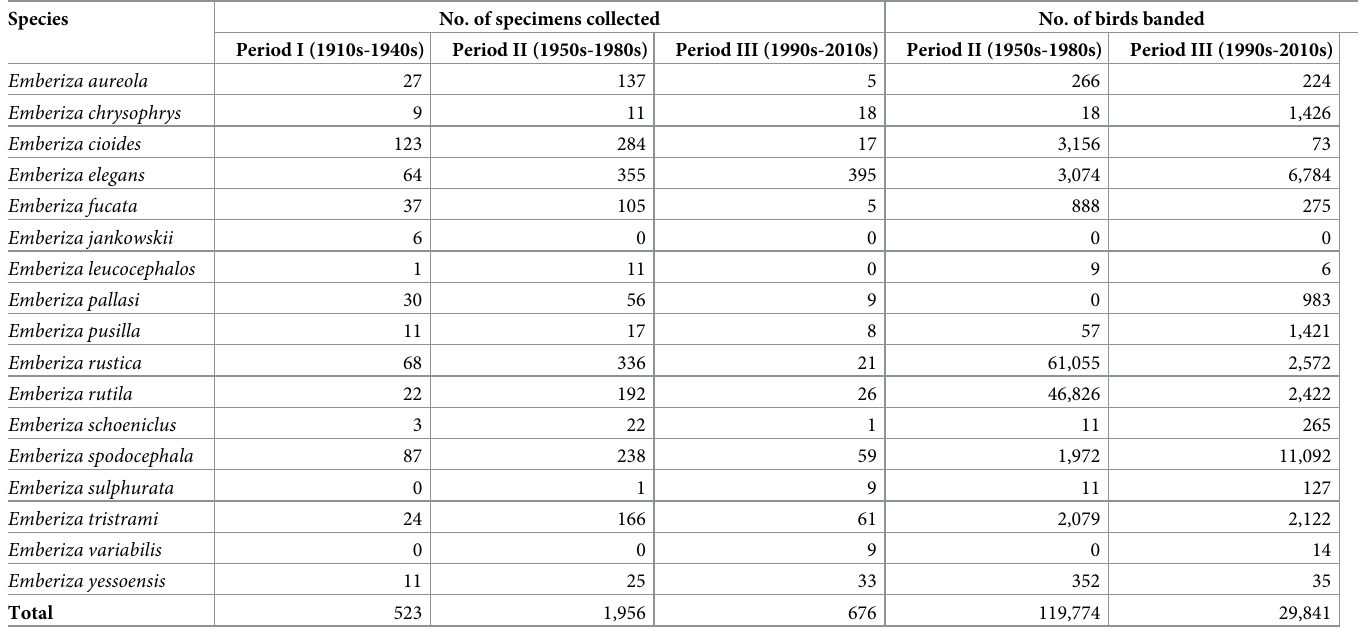
Table 1. The number of collected and banded Emberiza buntings in three different periods in Korea. There was no bird banding study prior to the 1950s (Period I).